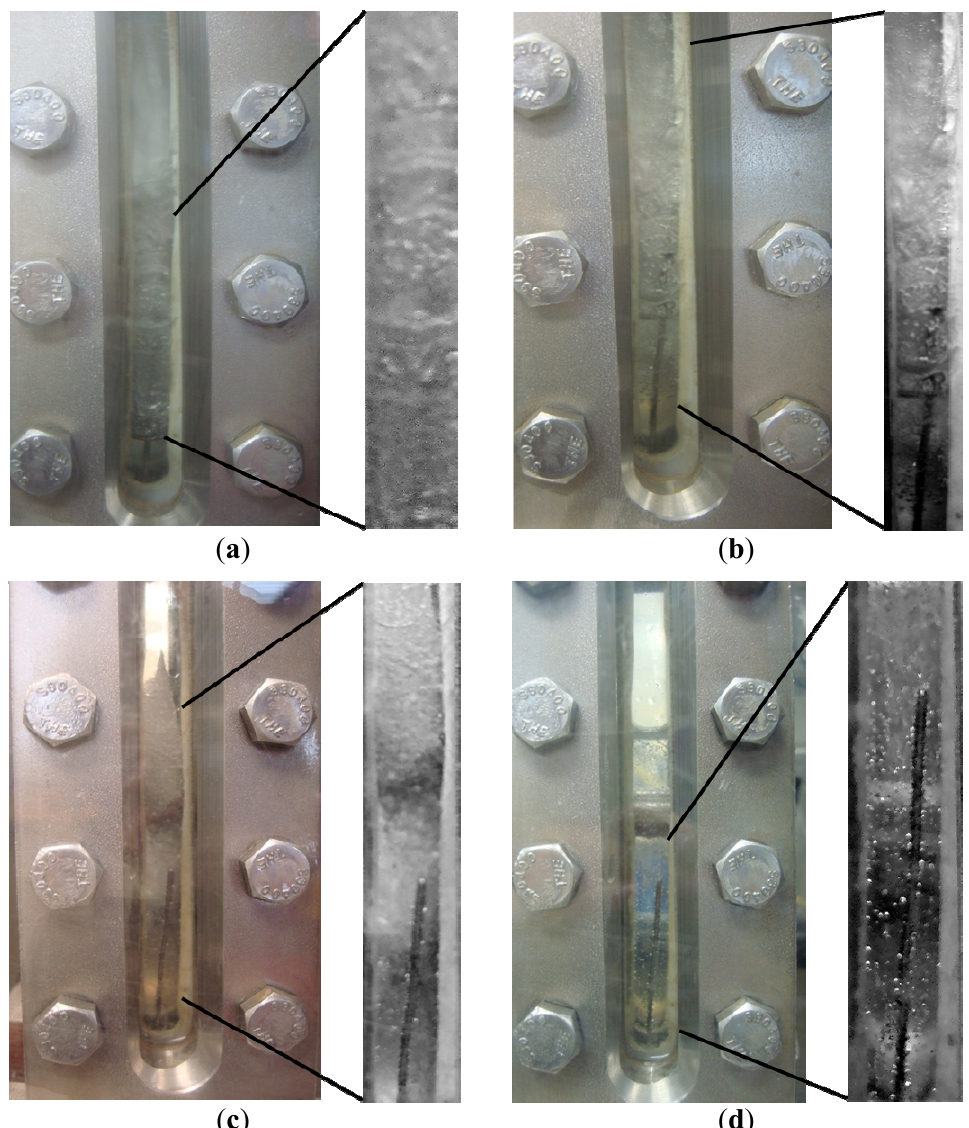
Figure 10. Time-resolved observations of the CH formation and during dissociation in Run 4 at ( a ) 574 psig, 1.38 °C; ( b ) 559 psig, 1.34 °C; ( c ) 629 psig, 0.77 °C; ( d ) 770 psig, 8.92 °C. These P/T conditions correspond to the numbers shown in the dissociation plot of Figure 9 where point 1 in Figure 9 represents (a) shown